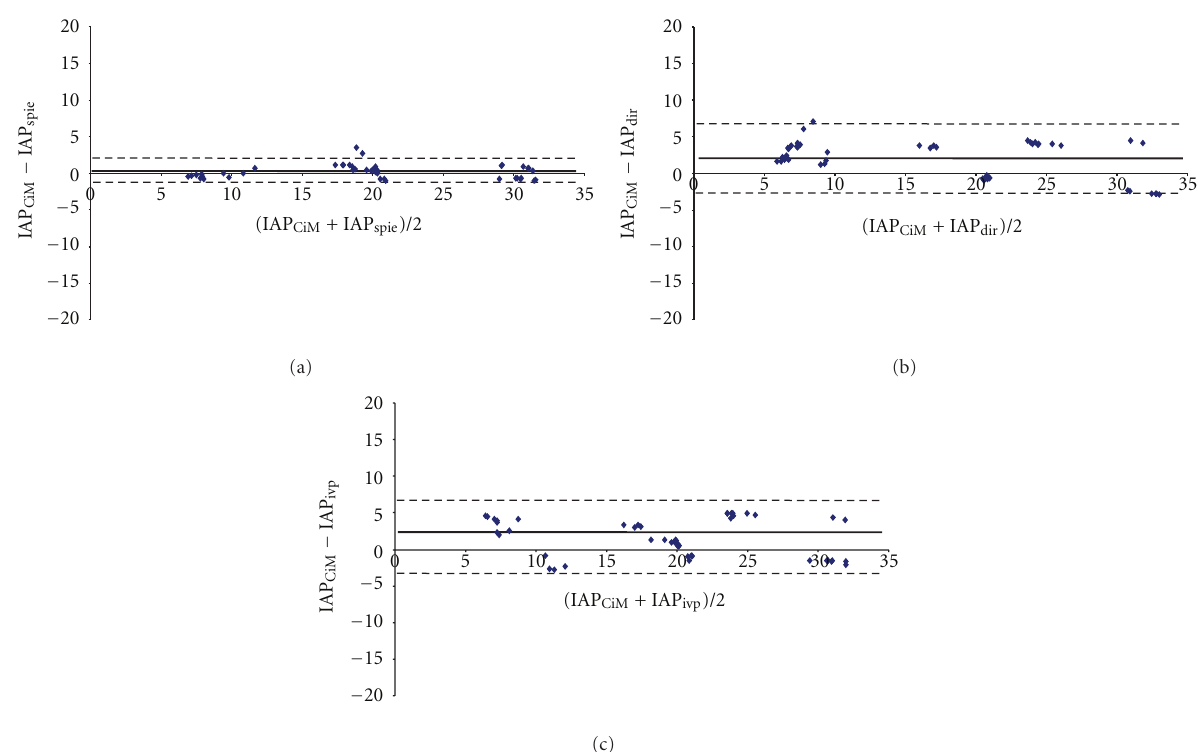
Figure 2: Bland Altman plots for comparing di ff erent methods measuring intra-abdominal pressure (IAP) in supine position. Horizontal full line: bias; horizontal dashed line: upper and lower limits of agreement. (a) CiMON balloon-tipped catheter IAP measurement (IAP CiM ) versus Spiegelberg balloon-tipped catheter IAP measurement (IAP spie ). (b) IAP CiM versus direct intraperitoneal IAP measurement (IAP dir ). (c) IAP CiM versus intravesical pressure IAP measurement (IAP ivp ).